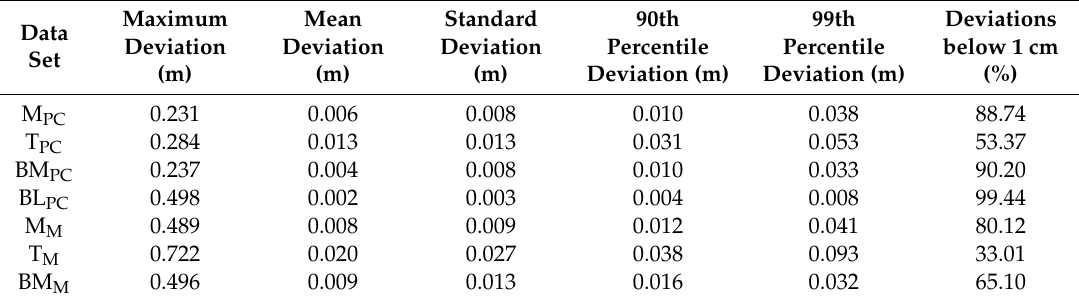
Table 8. Results from the distance analysis of the hall 101 segment.